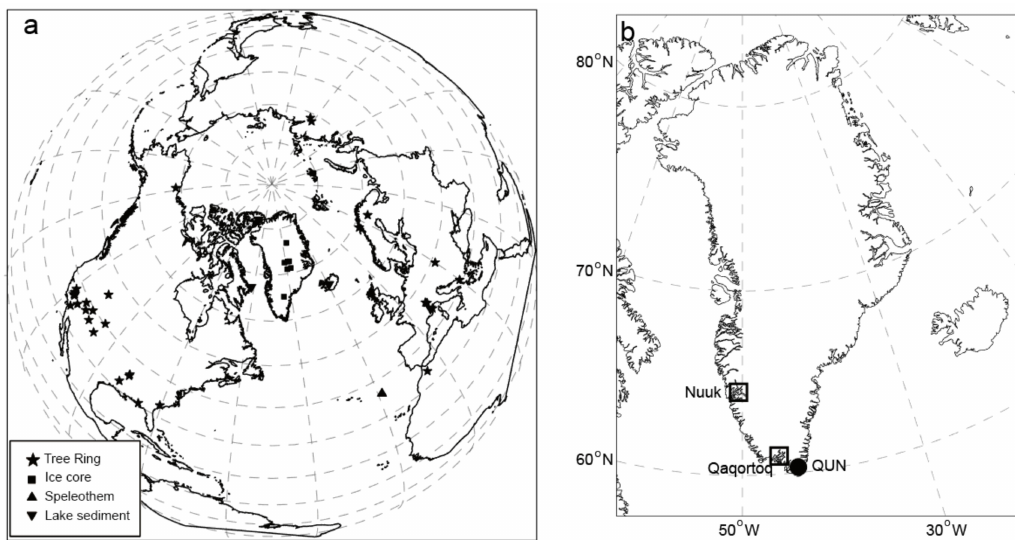
Figure 1. ( a ) Location of the ice cores, lake sediments, speleothems and tree rings that were used for NAO (North Atlantic Oscillation) reconstructions (modified from [26]). ( b ) Location of sampling site for the presented tree ring oxygen isotope (spot) and Nuuk and Qaqortoq meteorological stations